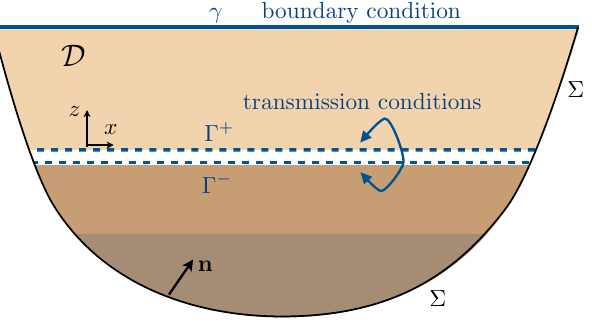
Figure 3. Domain where the energy is conserved in the absence of incoming/outcoming fluxes D through Σ . The effective boundary condition on γ and jump conditions between Γ ± in (3) result in additional effective energies in E t,b